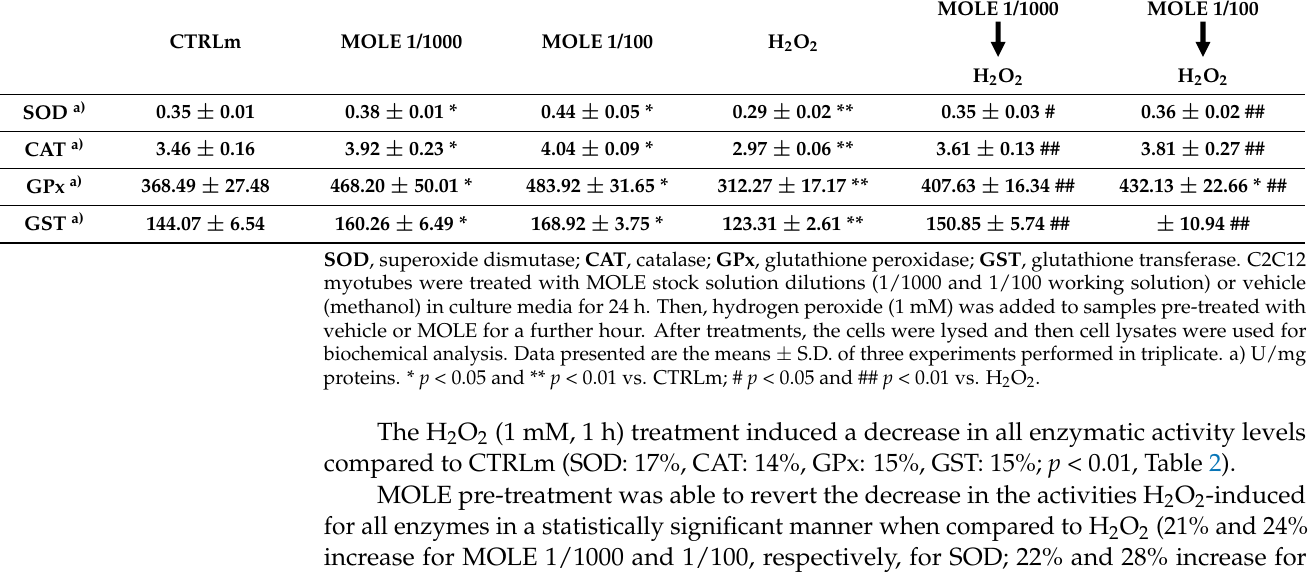
Table 2. Enzymatic activity analysis. Table 1. Total free thiols and Thioredoxin activity analysis Table 1. Total free thiols and Thioredoxin activity analysis CTRLm